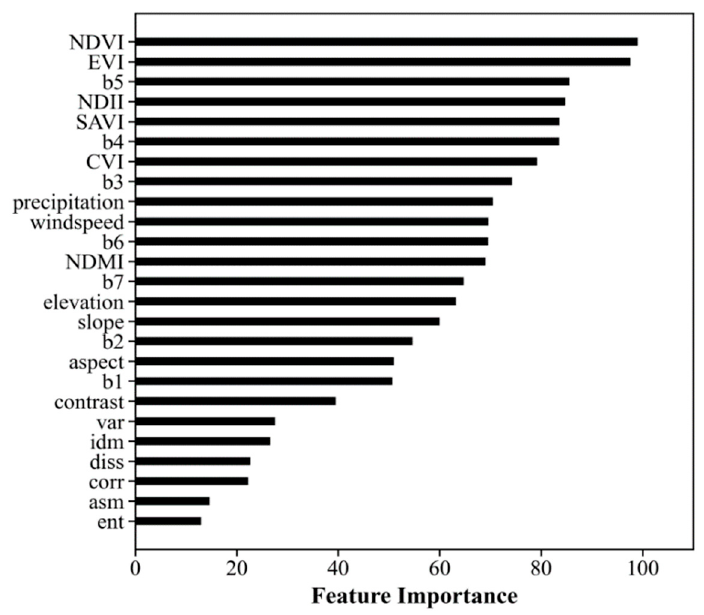
Figure 5. The importance ranks of variables in the Random Forest classifier/regressor models. Note: The importance values are normalized to 0–100; All variables except for precipitation, wind speed, elevation, slope, and aspect are represented by the changes before and after Rammasun.